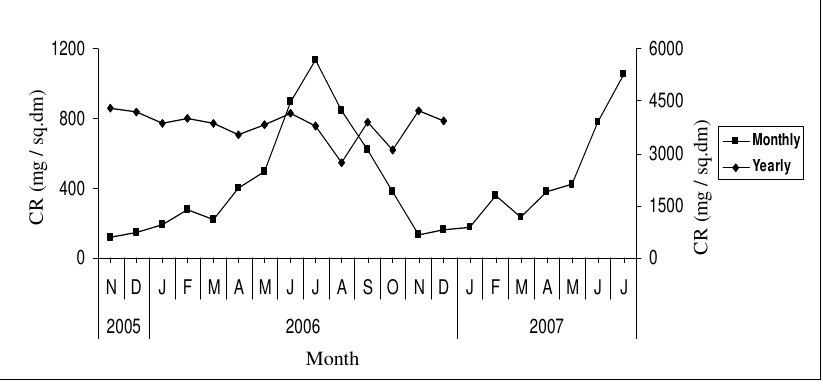
Figure 6. Monthly and yearly corrosion rate of mild steel under outdoor exposure during different months at marine